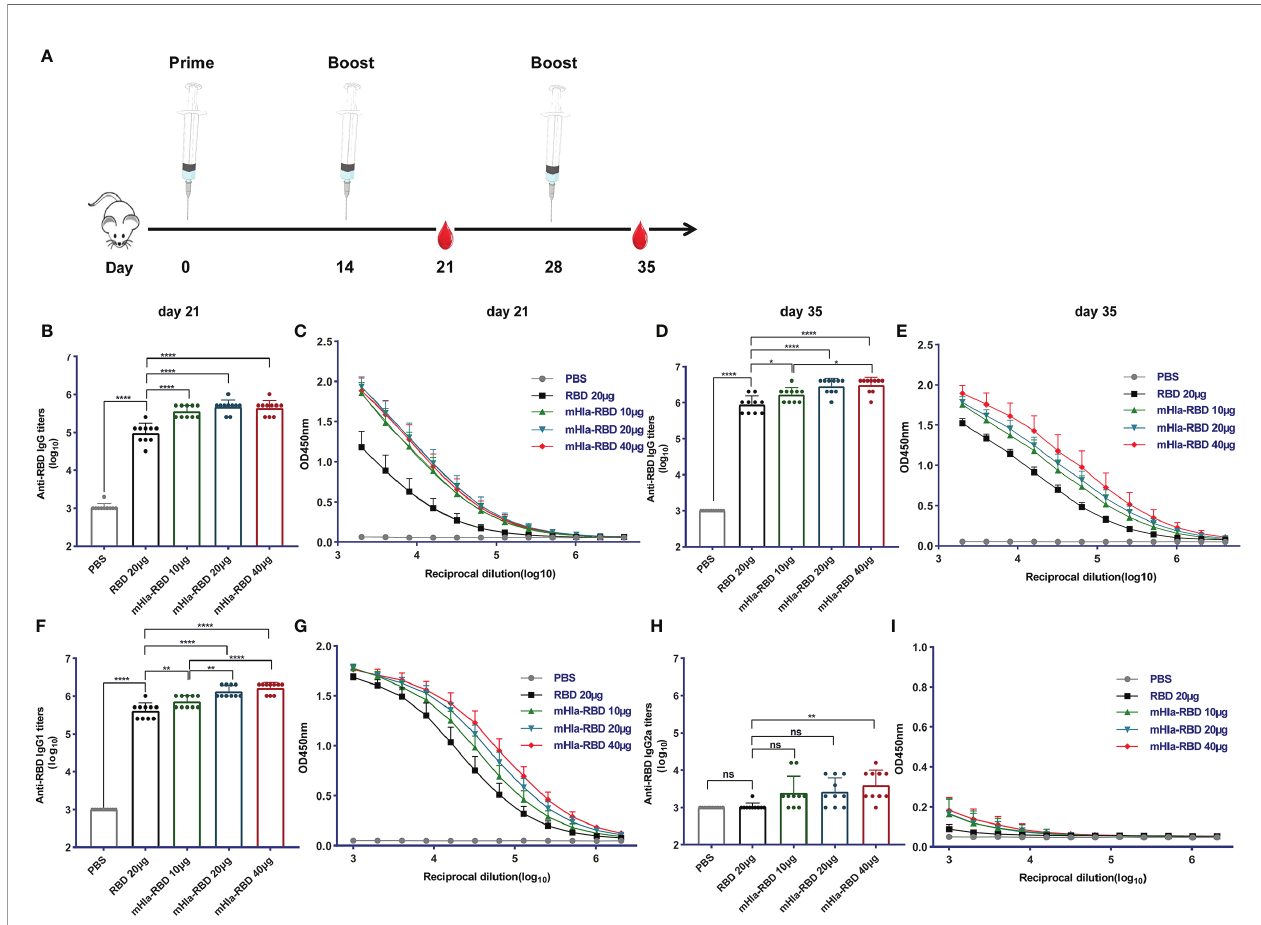
FIGURE 2 | mHla-RBD exhibited improved immunogenicity compared to the RBD monomer. (A) The immunization and sampling schematic diagram. BALB/c mice were immunized with PBS, RBD, and different dosages of mHla-RBD with alum adjuvant. One week after the second immunization (day 21), SARS-CoV-2 RBD- speci fi c immunoglobulin gamma (IgG) antibody titers (B) and different dilutions of IgG (C) were detected by ELISA. One-way ANOVA with Tukey ’ s multiple comparisons, **** p < 0.0001. One week after the third immunization (day 35), SARS-CoV-2 RBD-speci fi c immunoglobulin gamma (IgG) antibody titers (D) and different dilutions of IgG (E) were detected by ELISA. One-way ANOVA with Tukey ’ s multiple comparisons, * p < 0.05, **** p < 0.0001. Assessment of IgG1 antibody titer (F) and different dilutions of IgG1 (G) , one-way ANOVA with Tukey ’ s multiple comparisons, ** p < 0.01, **** p < 0.0001. Measurement of IgG2a antibody titer (H) and different dilutions of IgG2a (I) , one-way ANOVA with Tukey ’ s multiple comparisons, ** p < 0.01; ns, not signi fi